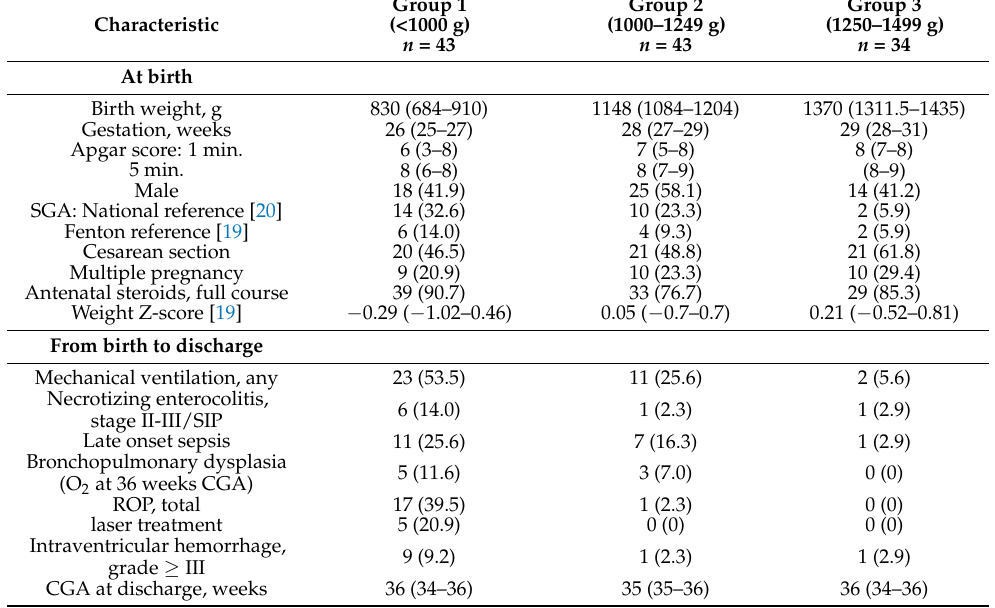
Table 1. Sample characteristics ( n =